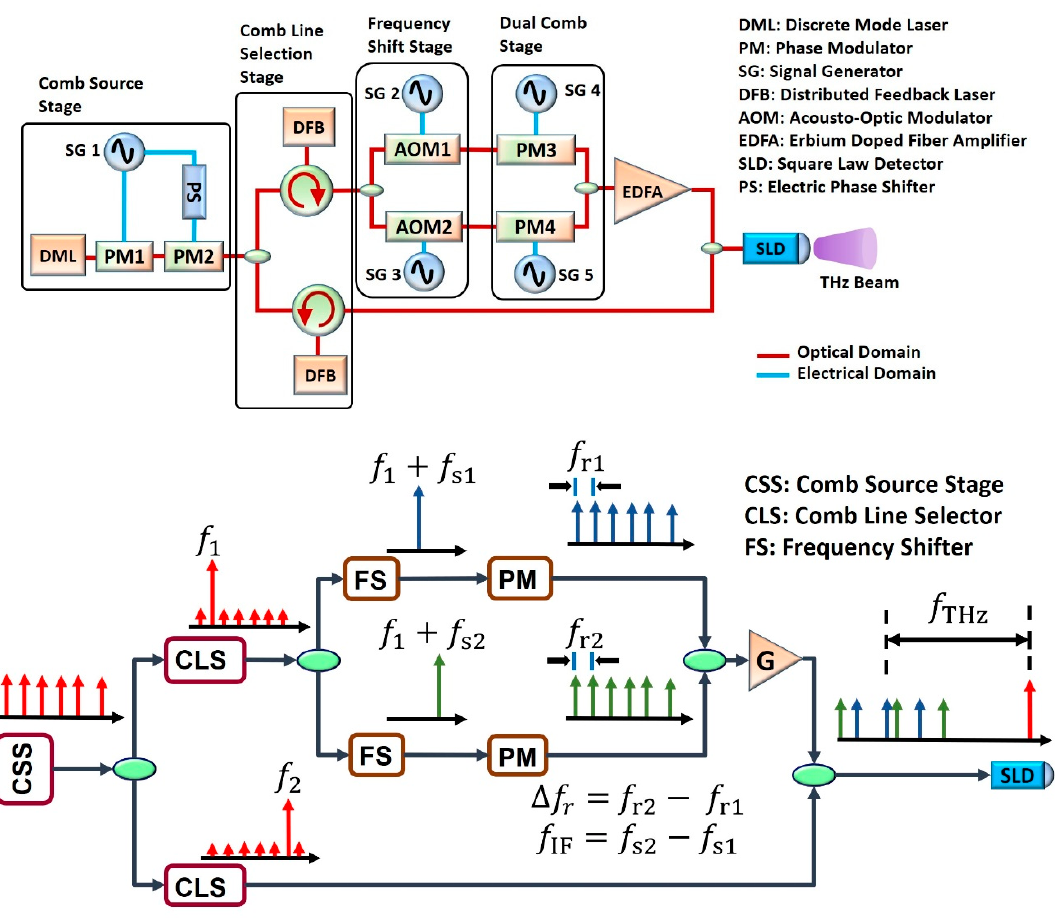
Figure 1. ( Up ) System Architecture of a benchtop THz Dual-Comb Spectrometer (TDCS). In the “comb